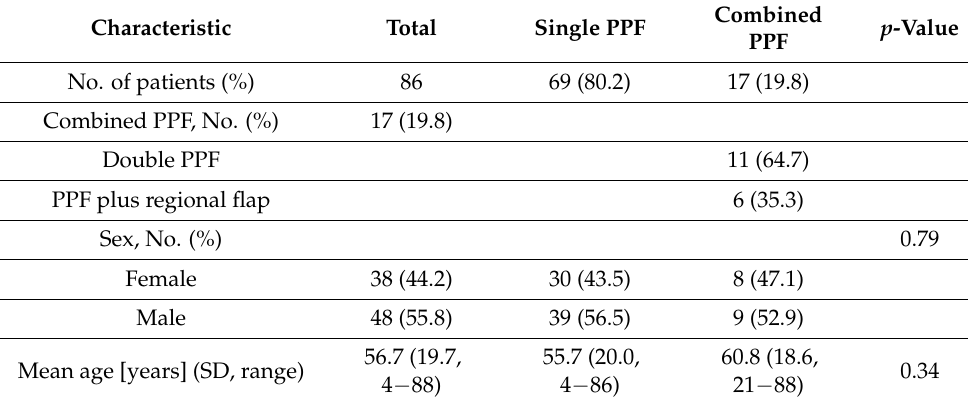
Table 2. Patient